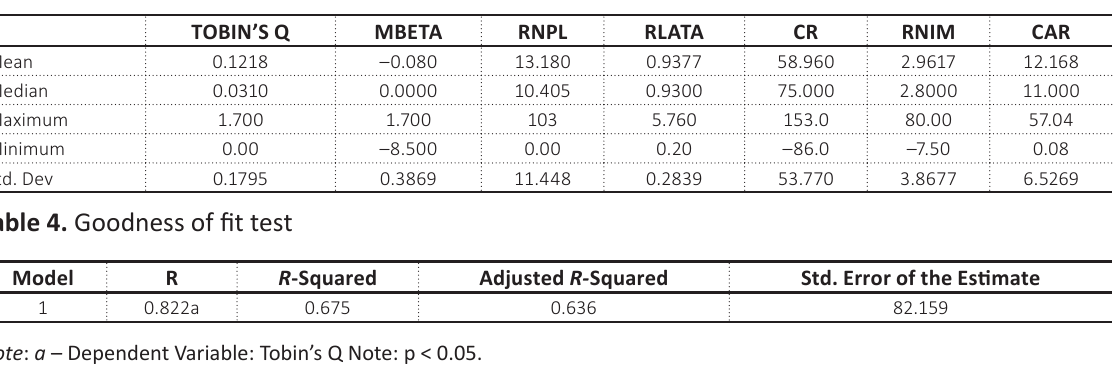
Table 3. Descriptive statistics